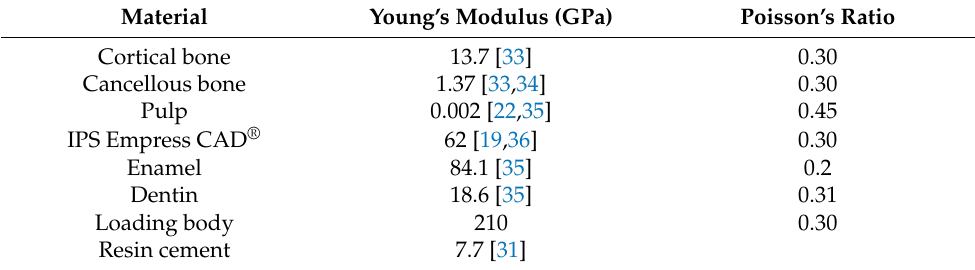
Table 3. Mechanical properties of all isotropic